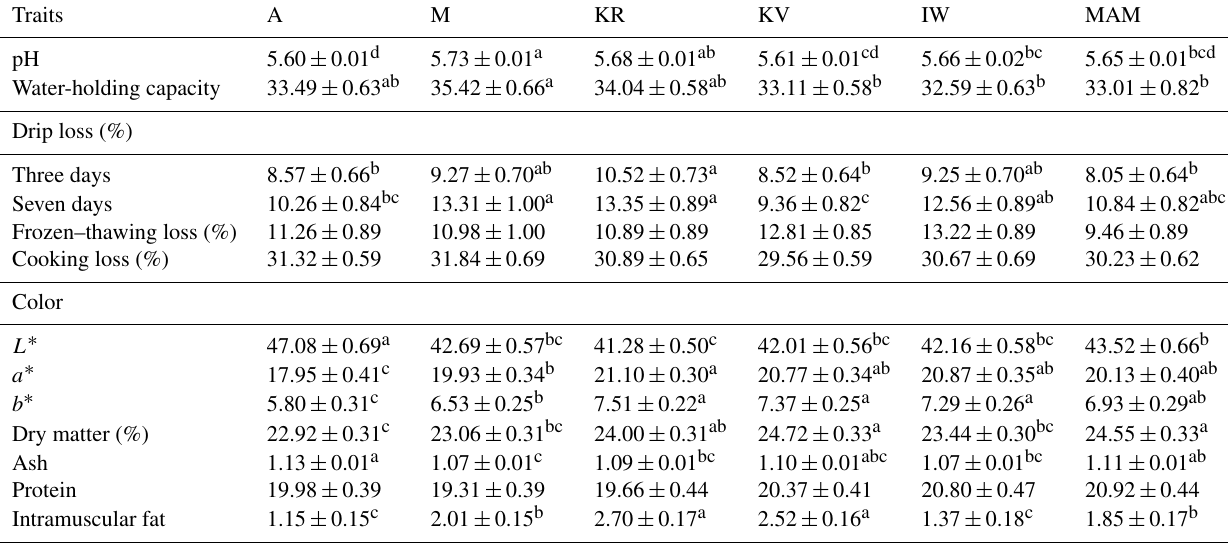
Table 3. Meat quality parameters and chemical composition of the semitendinosus muscle from male lambs born to Turkish indigenous sheep